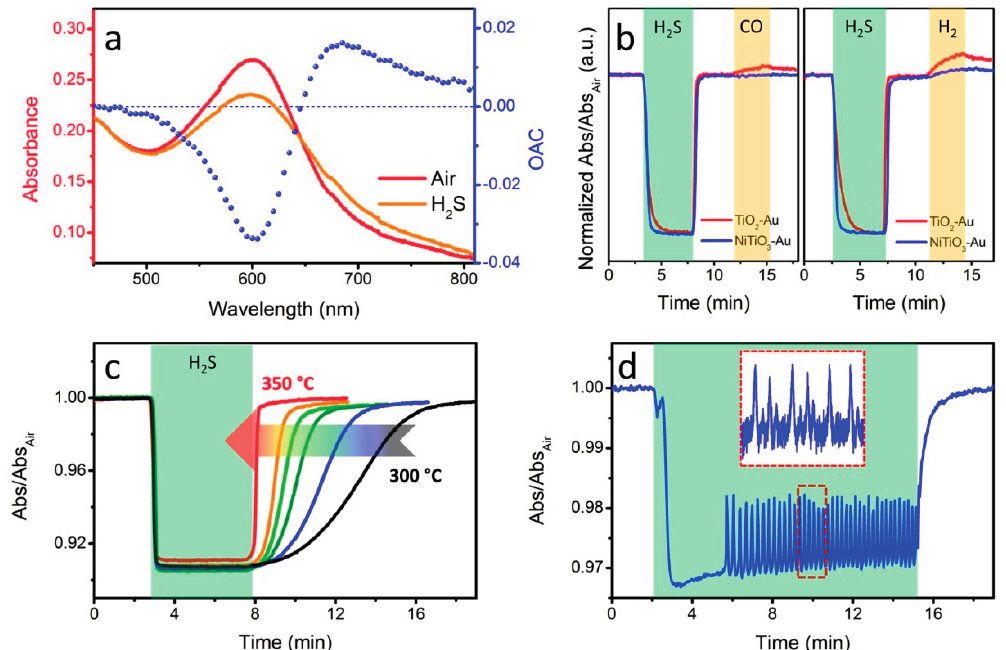
Figure 2. ( a ) Optical absorption spectra of a NiTiO 3 -Au film exposed to air and to 100 ppm H 2 S at 350 °C. The blue dotted plot (right vertical axis) shows the variation in absorbance as a function of the wavelength; ( b ) Time resolved tests for a NiTiO 3 -Au film showing the better response to H 2 S (100 ppm) and the absence of cross sensitivity to CO (1%) and H 2 (1%) when compared to TiO 2 -Au film (T = 350 °C, λ = 605 nm); ( c ) Time resolved tests for a NiTiO 3 -Au film exposed to 100 ppm H 2 S showing the variation in recovery times as a function of the operating temperature ( λ = 605 nm); ( d ) Oscillatory behavior of a NiTiO 3 -Au film exposed to 100 ppm H 2 S (T = 350 °C, λ = 590nm). The inset shows a zoomed view of a few